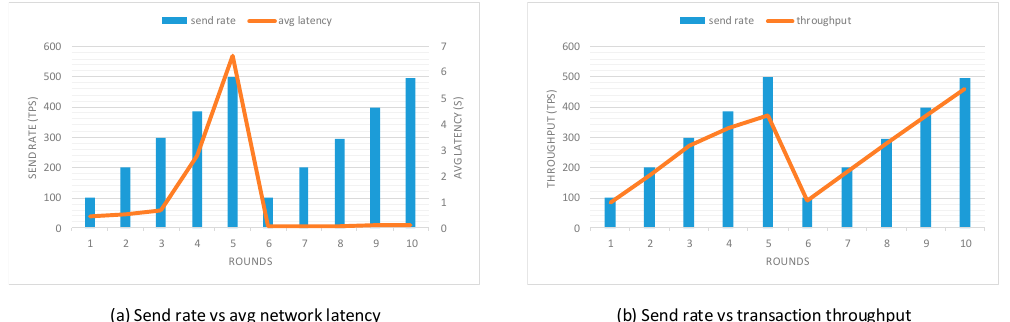
Figure 10. Performance evaluation with the 4-organization-2-peer network model.